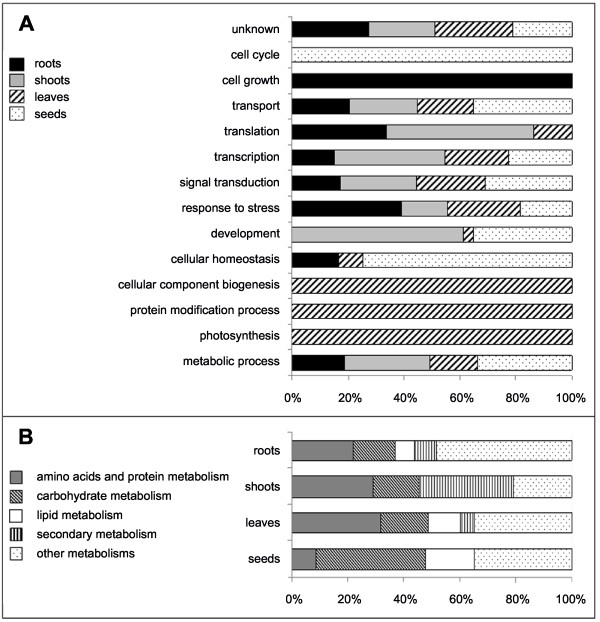
GO unigene annotation on microarray data. A - Percentage representation of differentially expressed genes from different flax tissues in different GO biological processes. B - Percentage representation of differentially expressed genes from different flax tissues in different metabolisms.